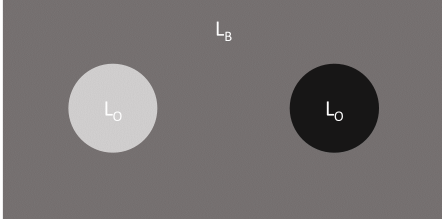
Figure 1. Contrast polarities; ( left ) The object appears brighter than its background (positive contrast); ( right ) The object appears darker than its background (negative contrast) [8].